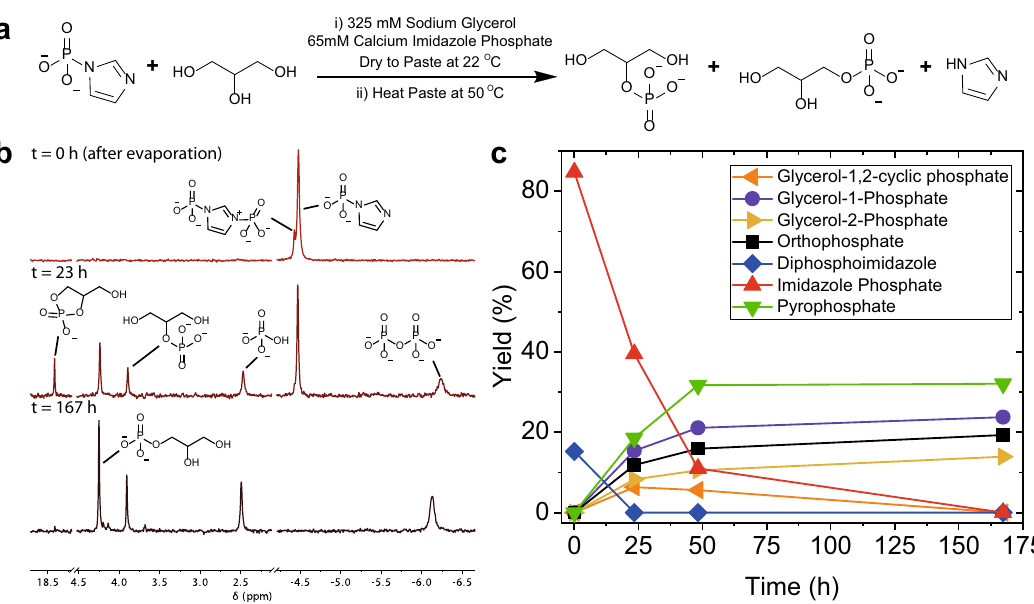
Fig. 2 The phosphorylation of glycerol by imidazole phosphate in paste conditions. a The phosphorylation reaction of glycerol by calcium imidazole phosphate in paste conditions after drying to a paste using the second method. b Representative 31 P-NMR spectra over time for the reaction of 0.13 mmol calcium imidazole phosphate and 0.65mmol glycerol in paste conditions at 50 °C. The paste was prepared by leaving 2.0 mL of a 65 mM calcium imidazole phosphate and 325 mM glycerol solution to dry for 48 h at 22 °C. The 31 P-NMR spectrum at t = 0 h was taken from the paste after the evaporation of water. During the drying stage diphosphoimidazole formed from the reaction of imidazole phosphate with itself. c Yields of phosphate- containing compounds over time for the reaction in a and b